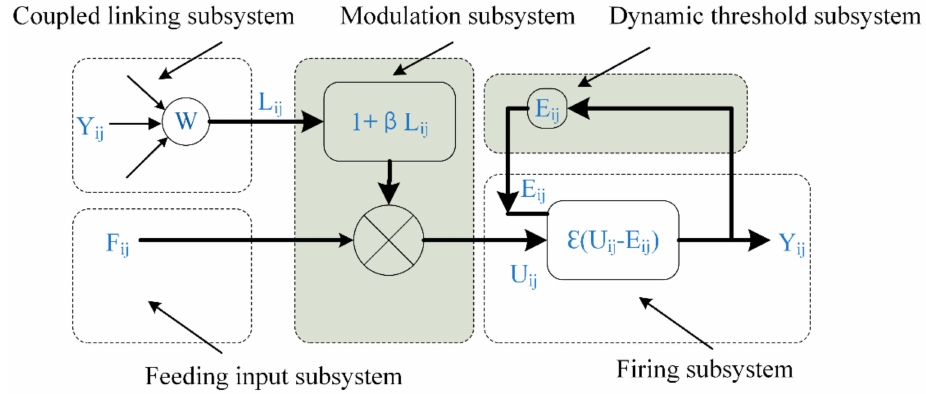
Figure 1. The structure of the simplified Pulse Coupled Neural